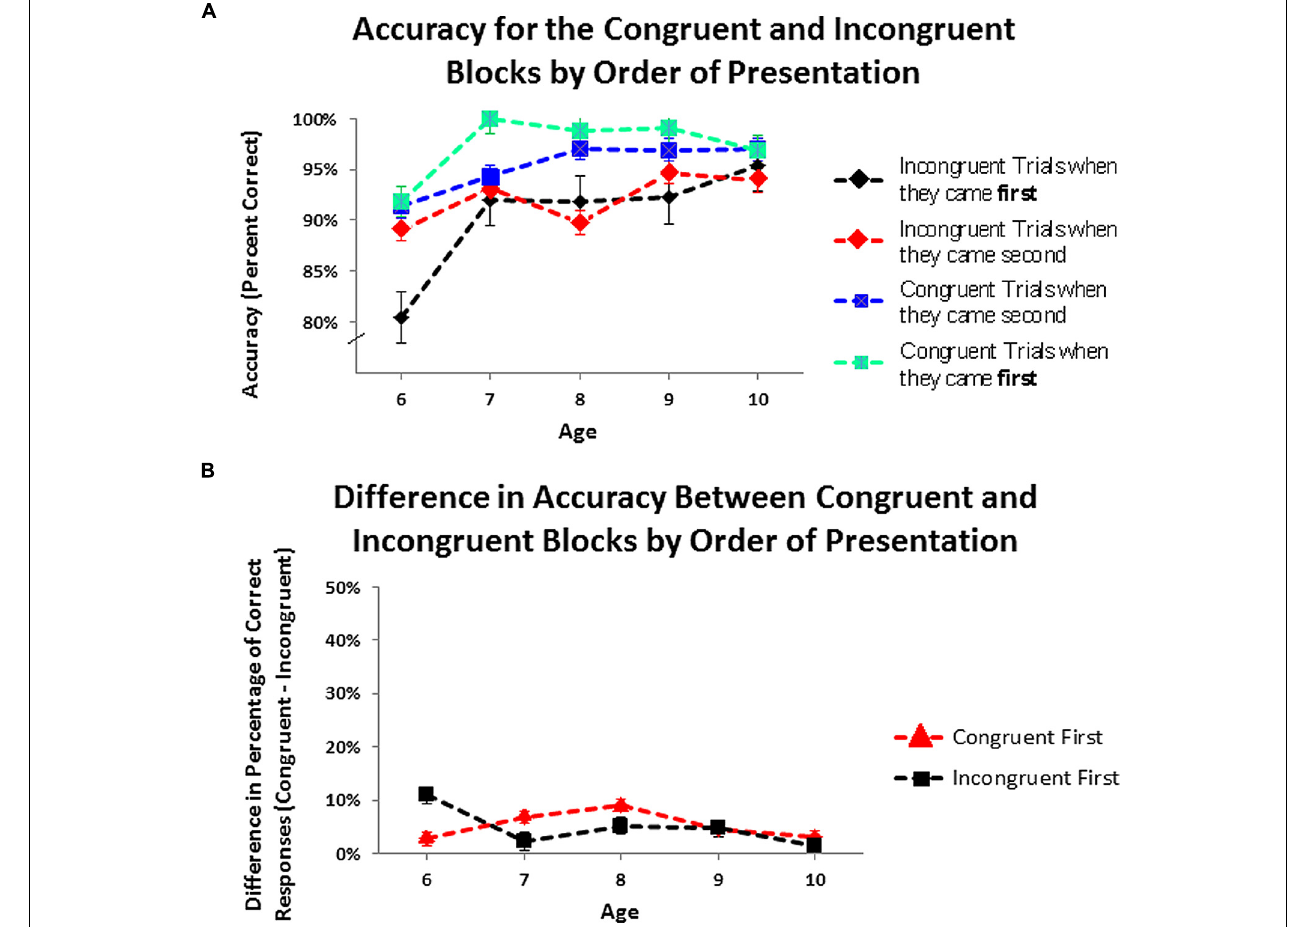
FIGURE 5 | (A) Accuracy on the congruent and incongruent blocks by order of presentation. (B) Difference in accuracy between congruent and incongruent blocks by order of presentation.Values greater than zero indicate that children were correct on more trialsin congruent than in incongruent blocks.